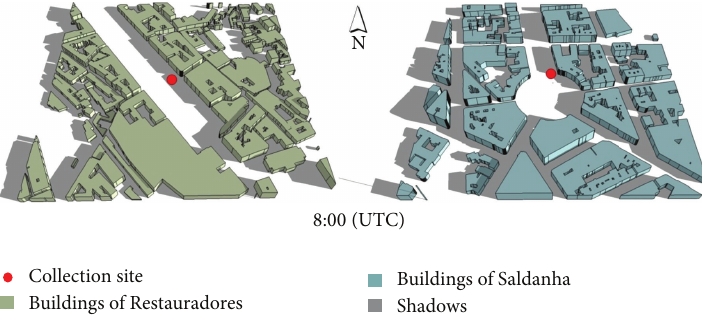
Figure 3: Building’s shadow effect during the equinox in Restauradores and Saldanha